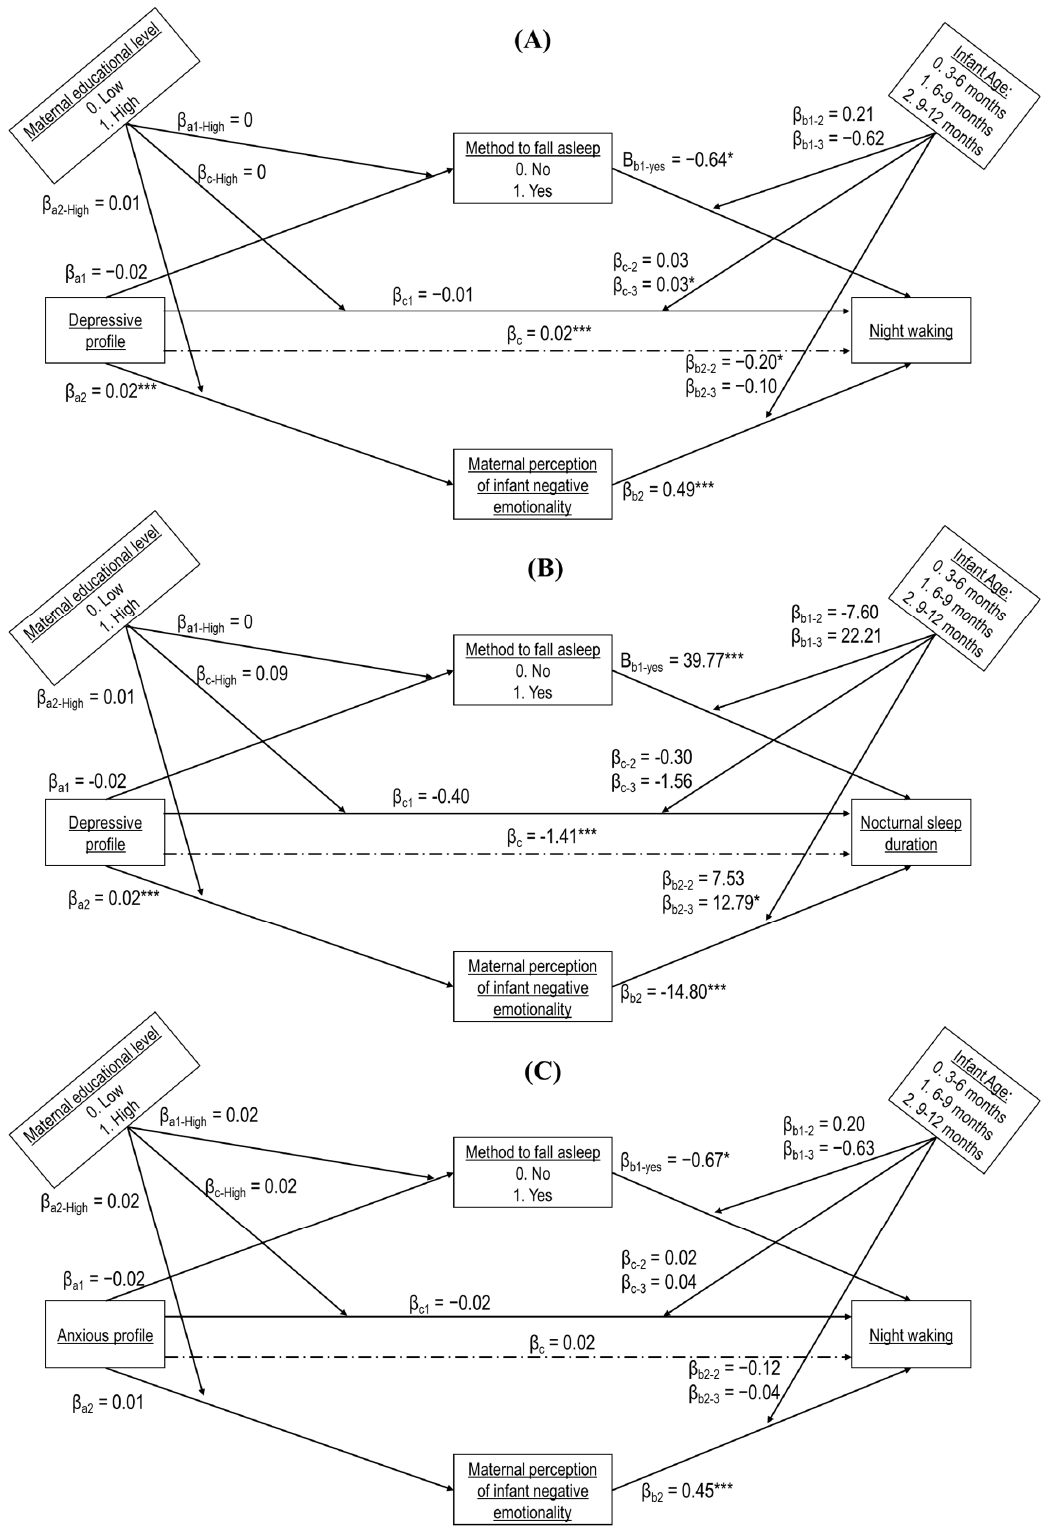
Figure 2. Model ( A ) displays the path model of the effect of the depressive profile on night waking, including mediators and moderators. Model ( B ) presents the path model of the effect of nocturnal sleep duration by the depressive profile, taking into account mediators and moderators. Model ( C ) represents the path model of the effect of the anxious profile on night waking, including